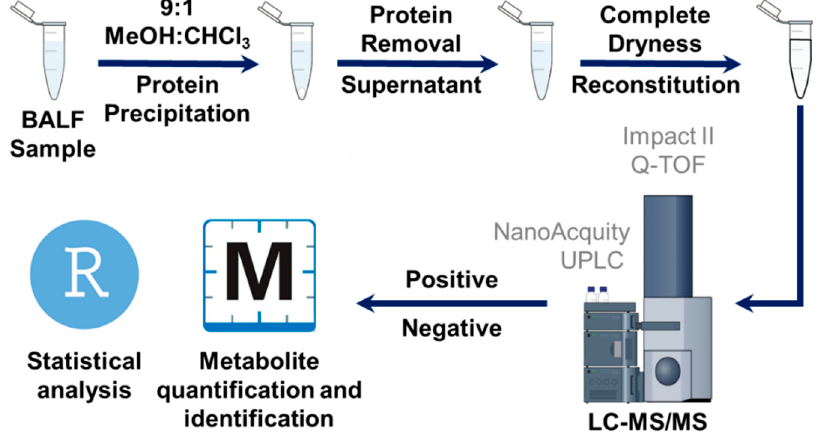
Figure 7. Sample workflow. Schematic view of sample preparation, data acquisition, and data analysis for BALF metabolomics.